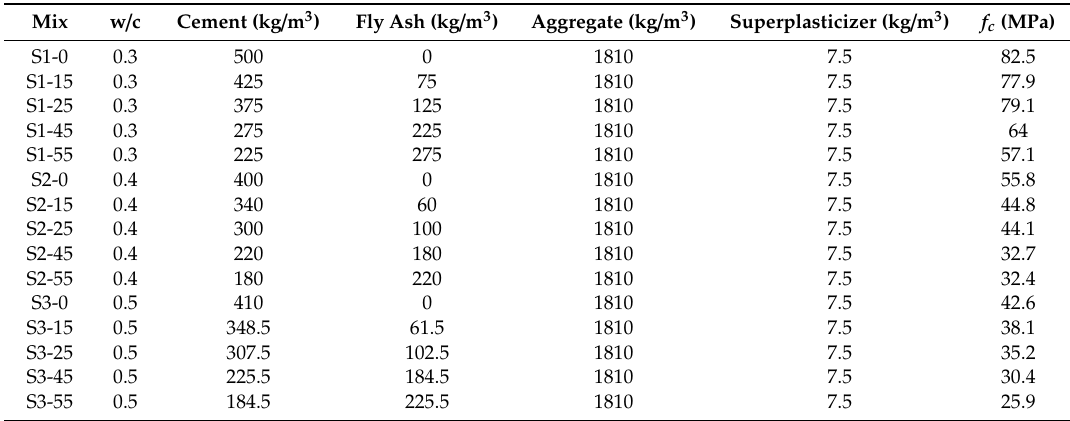
Table 1. The concretes tailored and tested by Lam et al. [11].